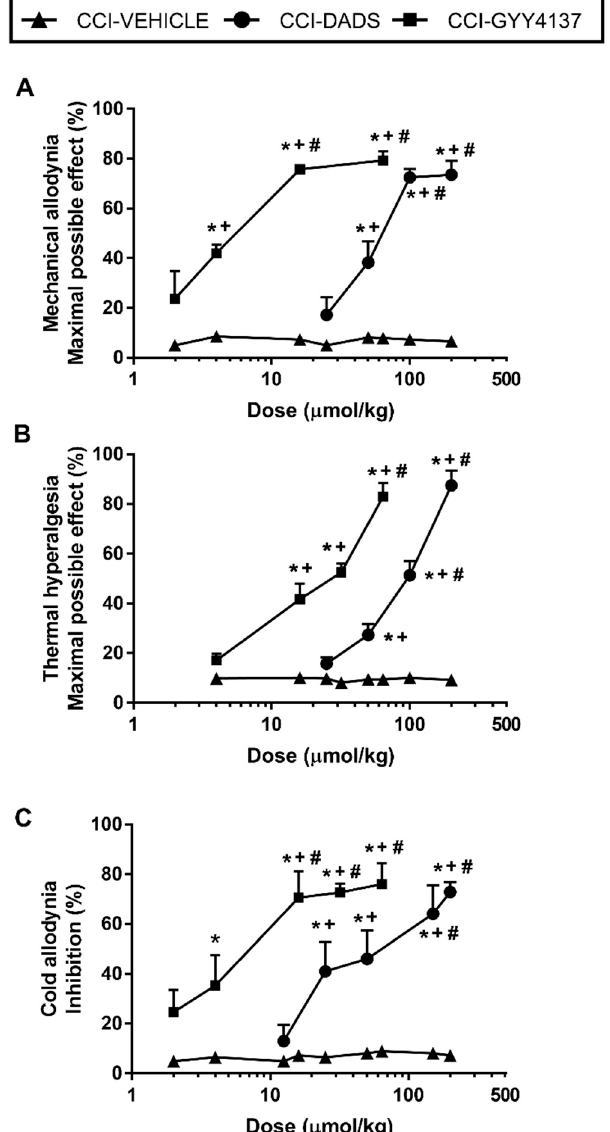
Figure 3. Effects of the acute administration of DADS and GYY4137 in the allodynia and hyperalgesia induced by sciatic nerve injury. Mechanical antiallodynic ( A ), thermal antihyperalgesic ( B ), and thermal antiallodynic effects ( C ) of different doses (logarithmic axis) of DADS and GYY4137 ( µ mols/kg) are shown. For each dose evaluated, * indicates significant differences vs. animals treated with vehicle, + indicates significant differences vs. the effect produced by the lowest dose of DADS or GYY4137, # vs. the effect produced by other doses of DADS or GYY4137 ( p < 0.05; one-way ANOVA, followed by Student–Newman–Keuls test). Data are expressed as mean values of maximal possible effect (%) for mechanical allodynia and thermal hyperalgesia and as % inhibition for cold allodynia. Mean values ± SEM ( n = 6 animals per dose).